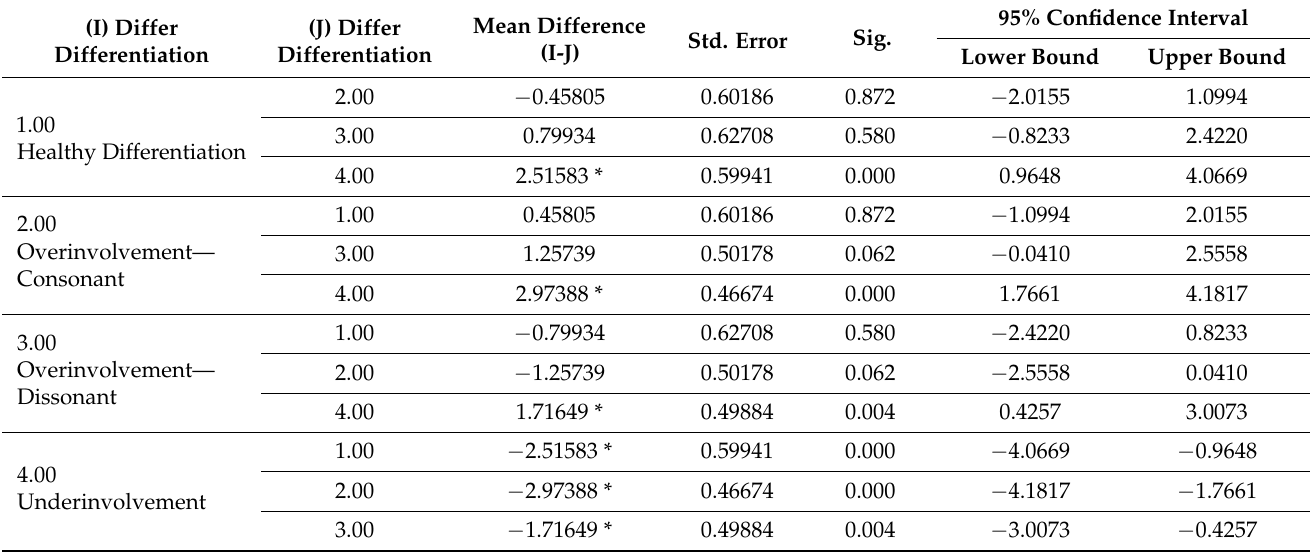
Table 6. Analysis of Variance Family History Knowledge and Stutman and Lich’s (1984) Differentia- tion Categories. SS df MS F Sig. Between Groups 356.292 3 118.764 14.737 0.001 ** Within Groups 1877.733 233 8.059 Total 2234.025 236 Note. ** p < 0.001. Table 7. Post Hoc Test: Tukey Multiple Comparisons (Family History Knowledge and Stutman and Lich’s (1984) Differentiation